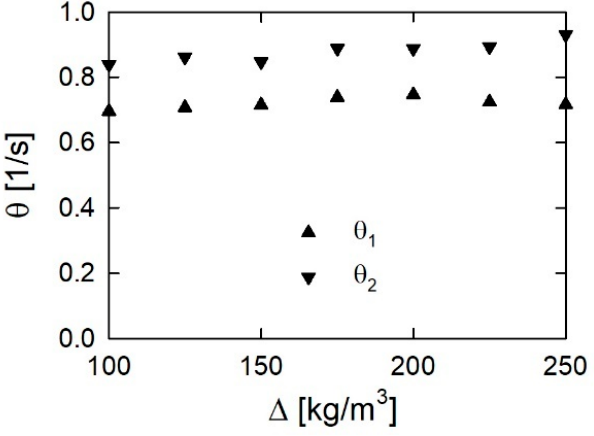
Figure 8. Values of coefficient θ , determined by two methods.